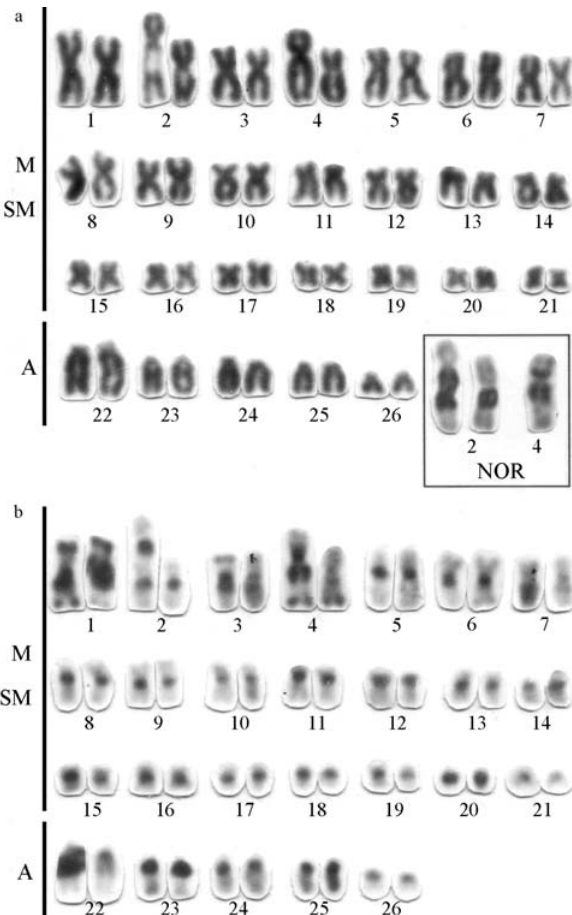
Figure1 -Karyotypeof Electrophoruselectricus fromtheAmazonRiver. a) Giemsa stained chromosomes; b) C-banded karyotype. In the insert, sil- ver-stained NORs: pair 2 evidencing strongly heteromorphic NOR bear-